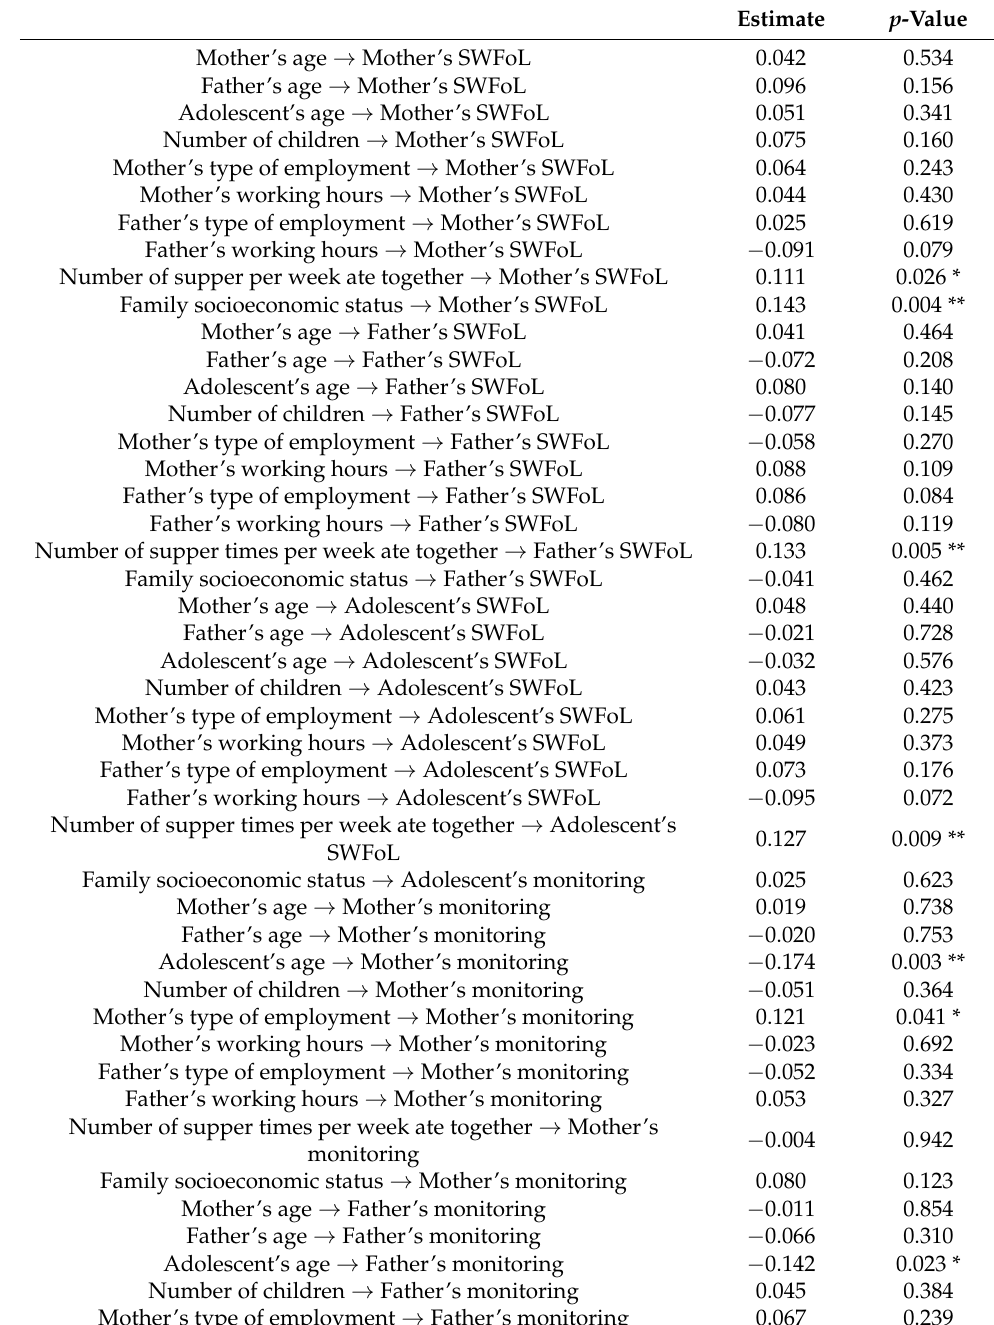
Table 3. Standardized effects estimate of control variables on satisfaction with food-related life (SWFaL) and monitoring (the perception regarding their parents’ monitoring practices in adolescents) in dual-earner parents with adolescent